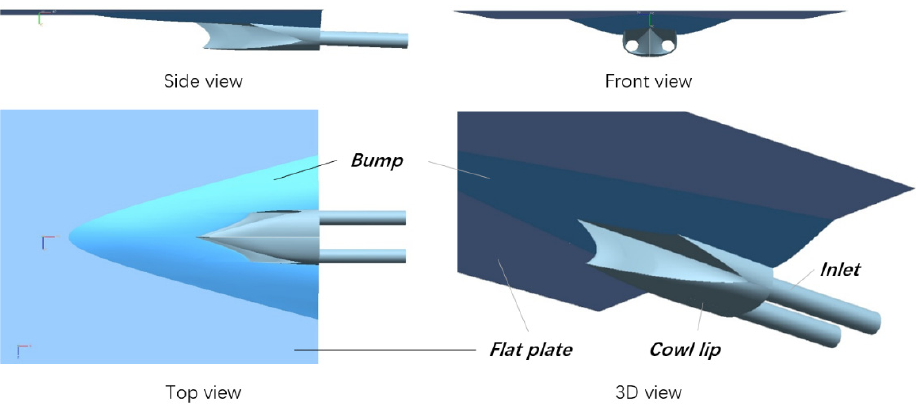
Figure 9. Configuration of the new spillage ‐ adaptive bump inlet.